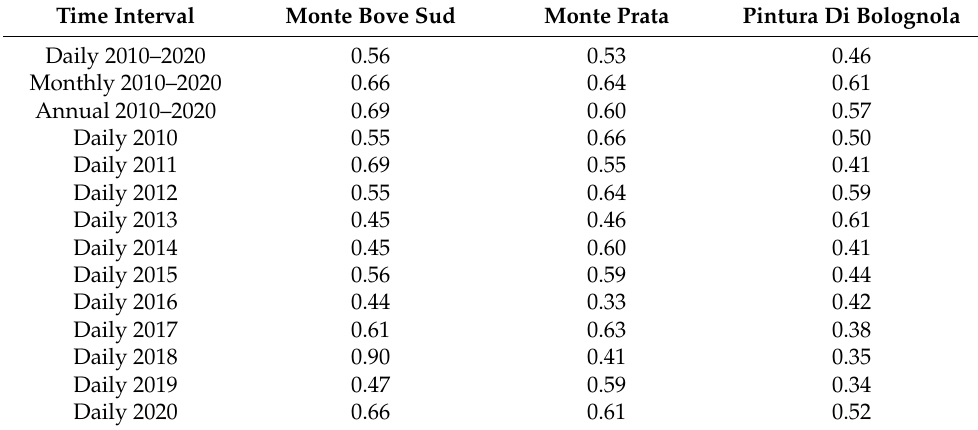
Table 1. Correlation coefficient between IMERG and rain gauges data in the three locations: Monte Bove Sud, Monte Prata and Pintura di Bolognola.